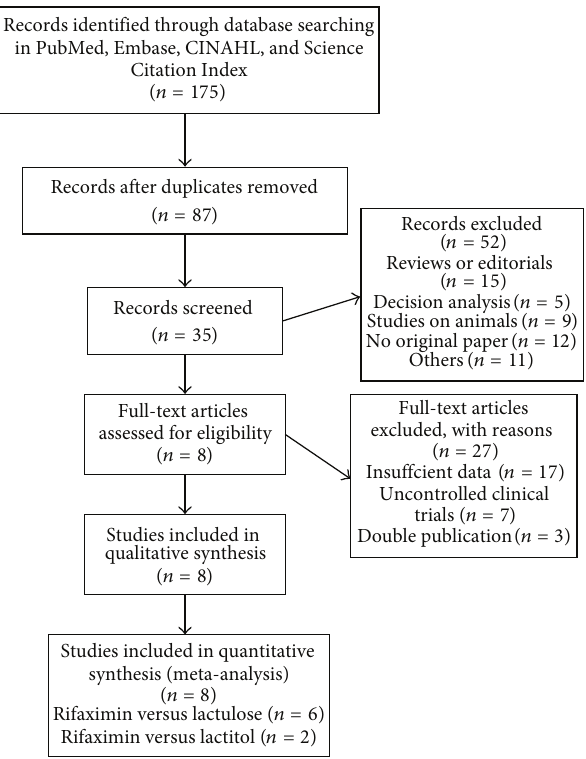
Figure 1: Flow diagram of included studies of